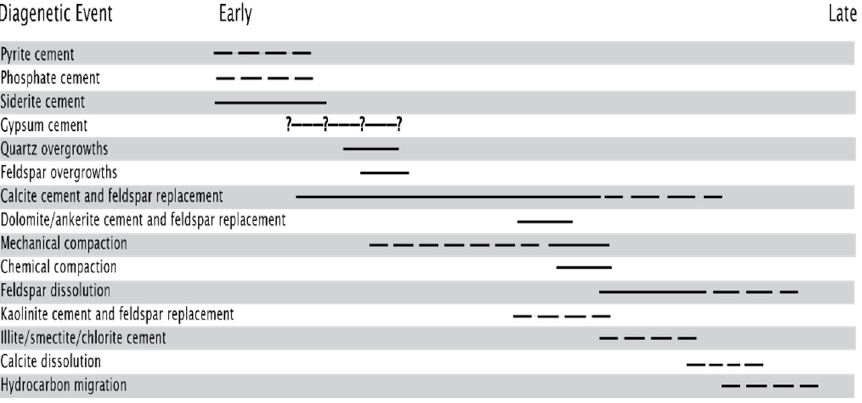
Figure 9. Paragenetic sequence for Morrow B sandstones.